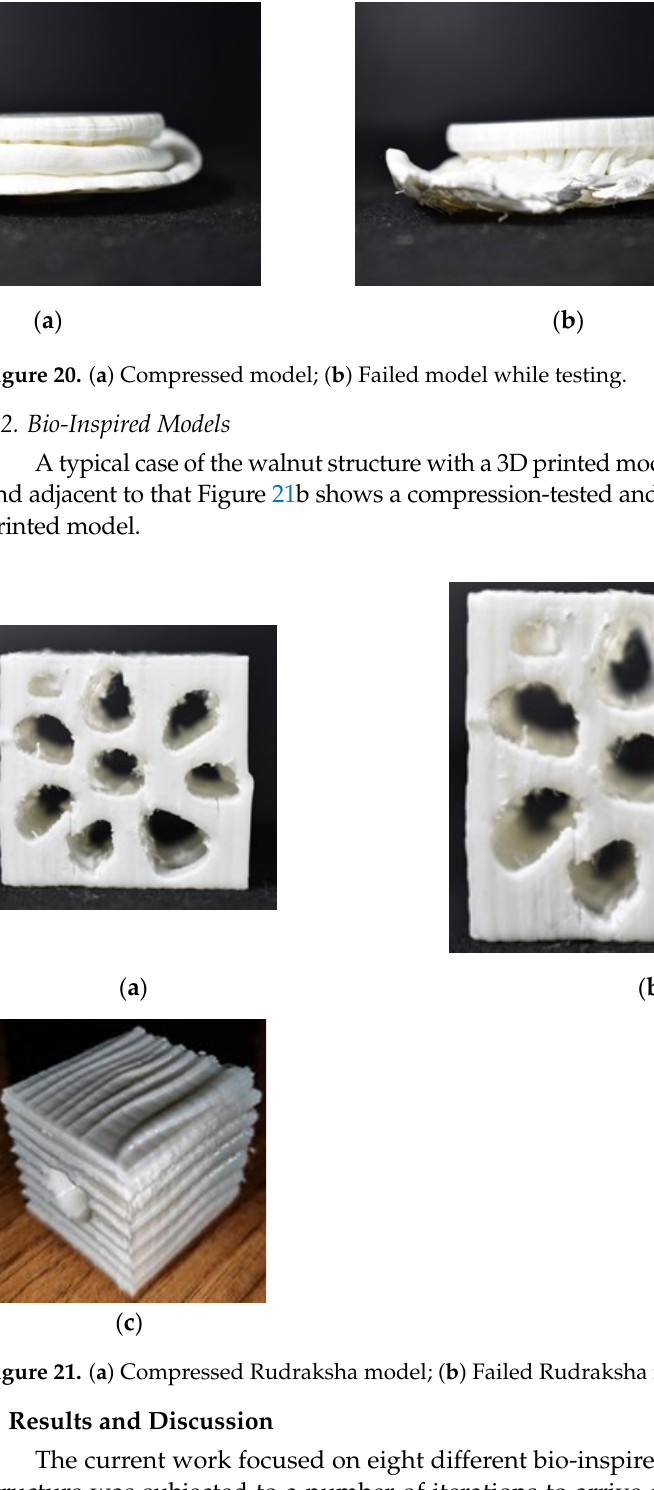
Figure 19. ( a ) A 3D printed AGM; ( b ) Tested model with failed structure.